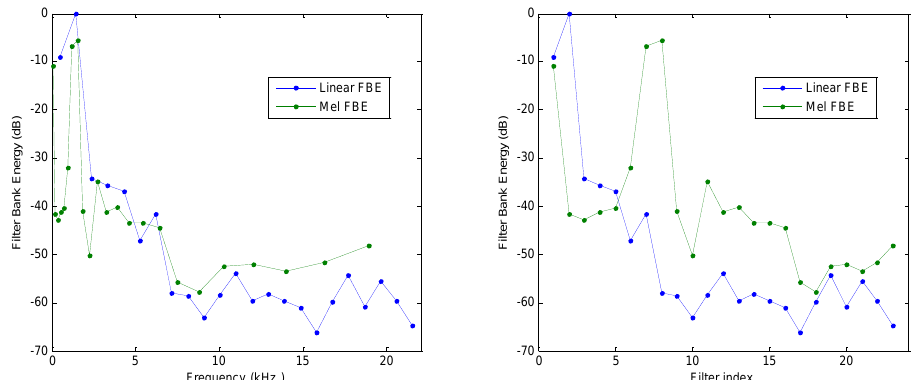
Figure 11. Linear and mel Filter Bank Energy: ( left ) horizontal frequency scale; ( right ) horizontal mel scale (filter index).